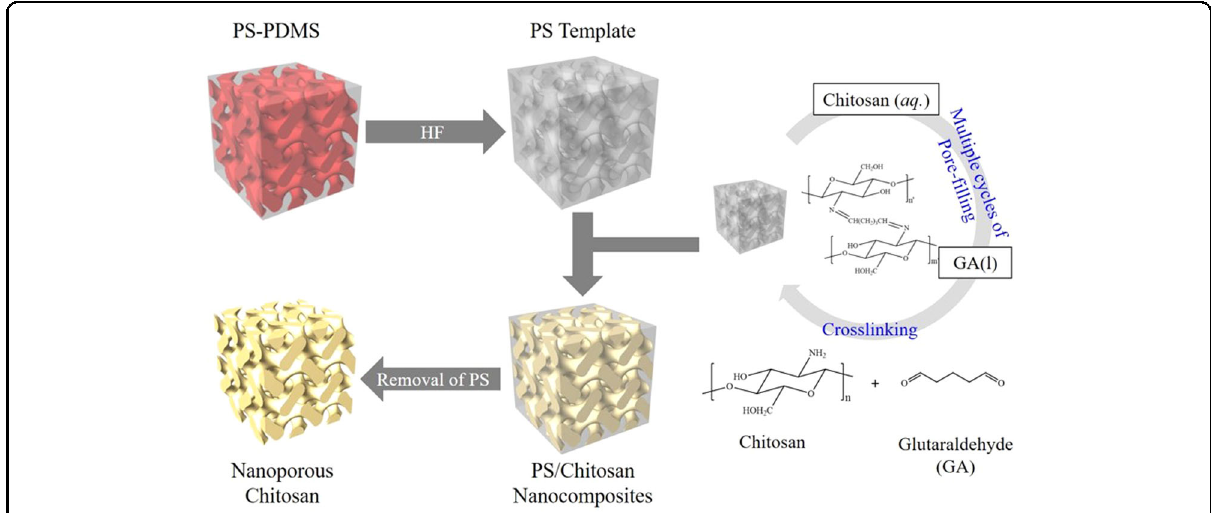
Fig. 1 Schematic illustration of fabricating gyroid-structured nanoporous chitosan. Solution-cast PS- b -PDMS with gyroid-texture is fi rst treated with hydro fl uoric acid aqueous solution to etch the PDMS block. After degeneration of the PDMS, nanoporous PS with gyroid-structured nanochannels can be obtained. Subsequently, chitosan aqueous solution with the crosslinking agent is pore- fi lled into the PS template through multiple pore- fi lling process, giving gyroid-structured PS/chitosan nanocomposites. After removal of the PS template, well-ordered chitosan with gyroid-structured nanonetworks can be